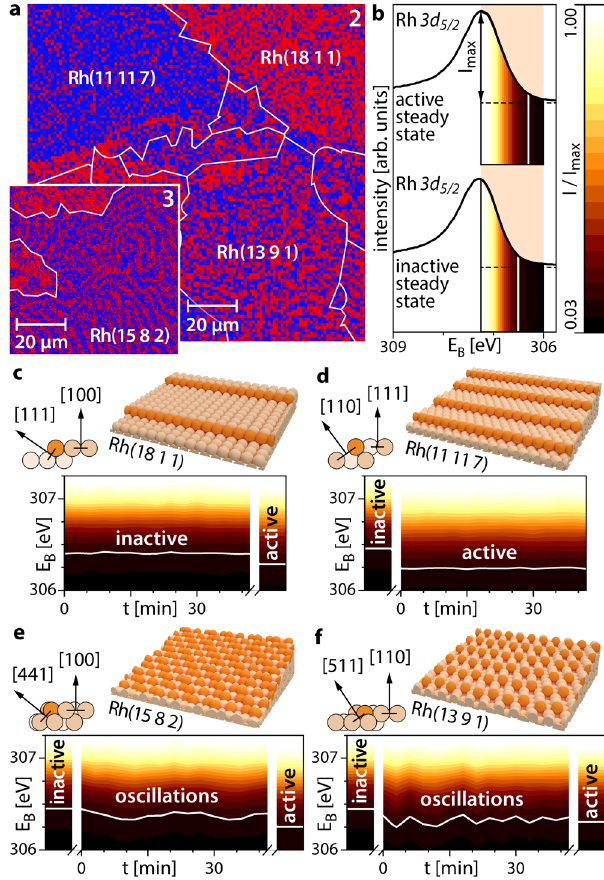
Fig. 3 Coexisting multistates in catalytic H 2 oxidation on Rh. a Rh 3d 5/2 SPEM map of 2/3 (red) and 1/4 (blue) oxygen-bound Rh states of regions 2 and 3 in Fig. 1a during H 2 oxidation at T = 453 K, p O2 = 1.1 × 10 − 6 mbar, p H2 = 1.2 × 10 − 6 mbar; b reference Rh 3d 5/2 XPS spectra for the catalytically active and inactive steady states on Rh(13 9 1) at T = 453 K, p O2 = 1.1 × 10 − 6 mbar, p H2 = 1.6 × 10 − 6 and 0.9 × 10 − 6 mbar, respectively. The XPS signal intensity in the energy window 306 – 307.25 eV is colour- coded; c atomic ball model of the Rh(18 1 1) surface and colour-coded spectral time series in the multi-state regime. The colour-coded active steady state reference spectrum from ( b ) is shown on the right hand side; d the same as in ( c ) but for the Rh(11 11 7) surface, with a reference spectrum of the inactive steady state on the left-hand side; e the same as in ( c ) but for the Rh(15 8 2) surface, with two reference spectra on both sides; f the same as in ( e ) but for Rh(13 9